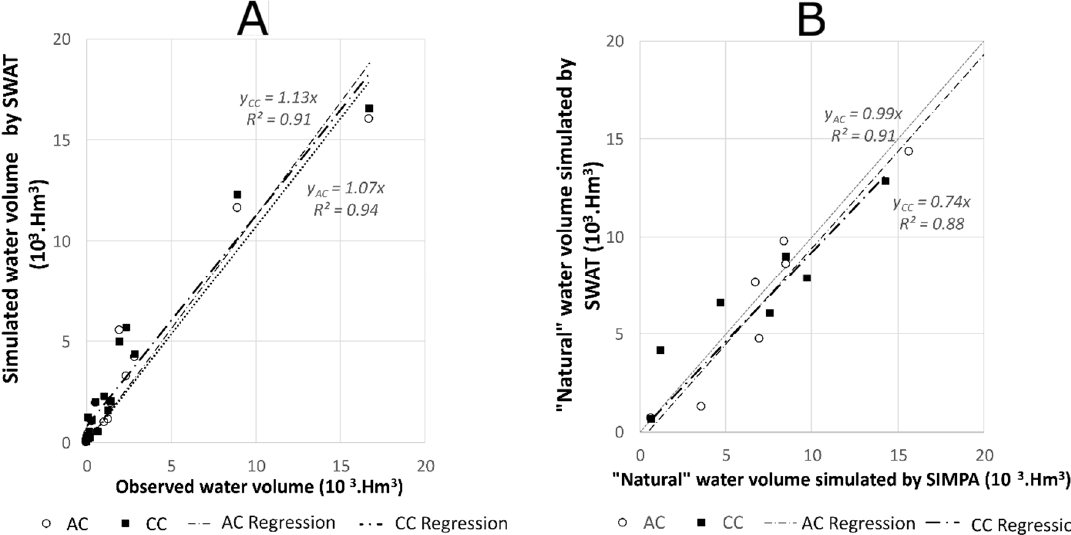
Figure 6. Simulated CC (conventional calibration) and AC (additional calibration) versus ( A ) observed annual water volume and versus ( B ) SIMPA simulation for the main watersheds of the SUDOE territory (inter-annual averages from 2000 to 2010).